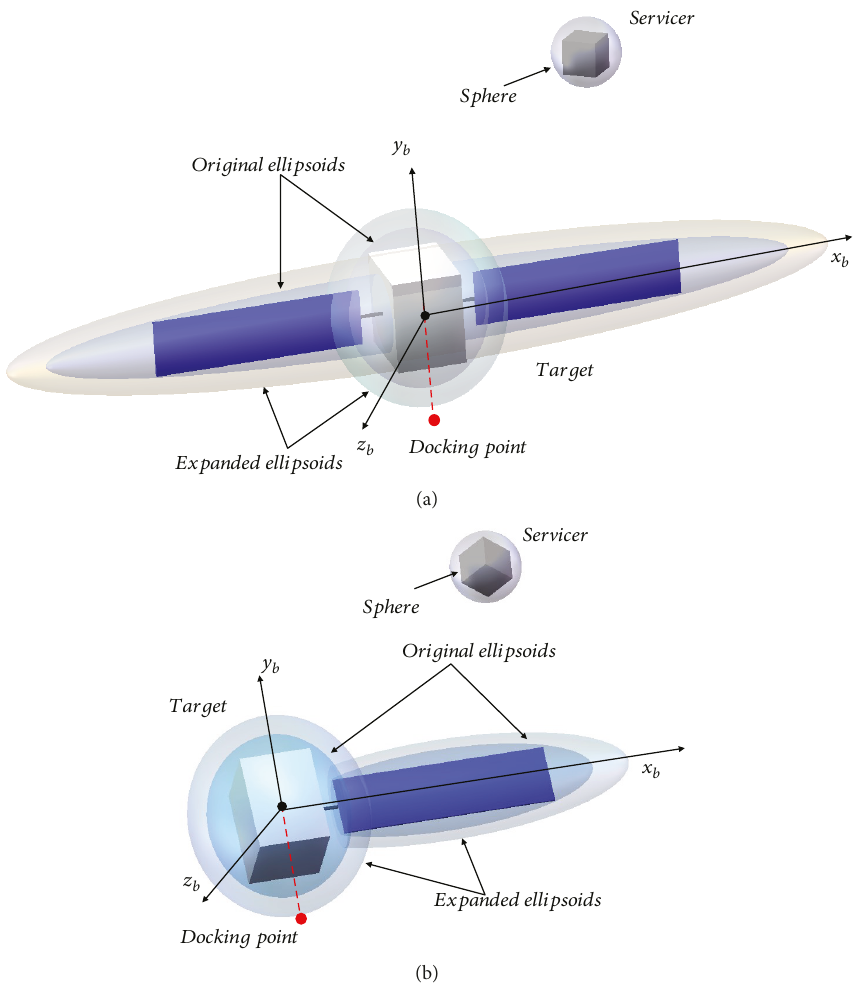
Figure 4: The double-ellipsoid composite envelope strategy for (a) the fi rst type of a failed spacecraft and (b) the second type of a failed